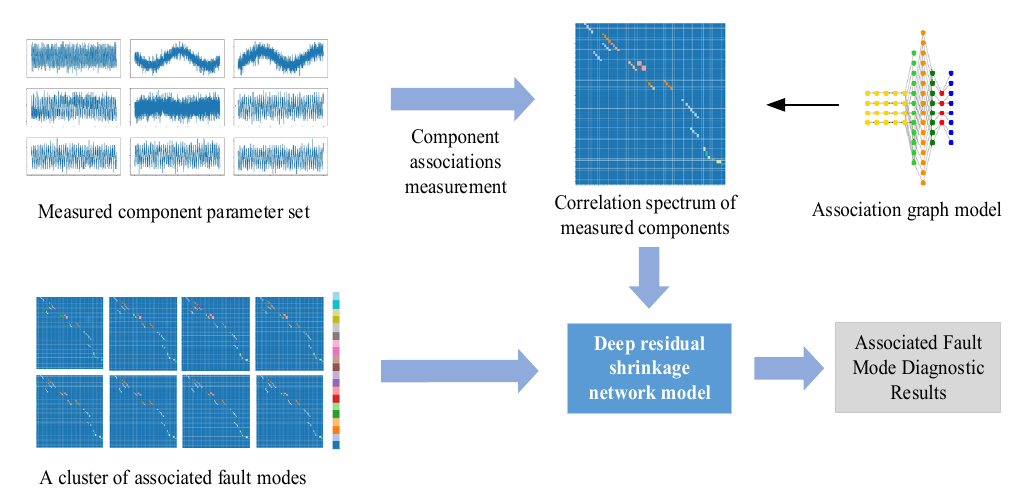
Figure 7. Schematic graph of power supply system associated fault diagnosis model.